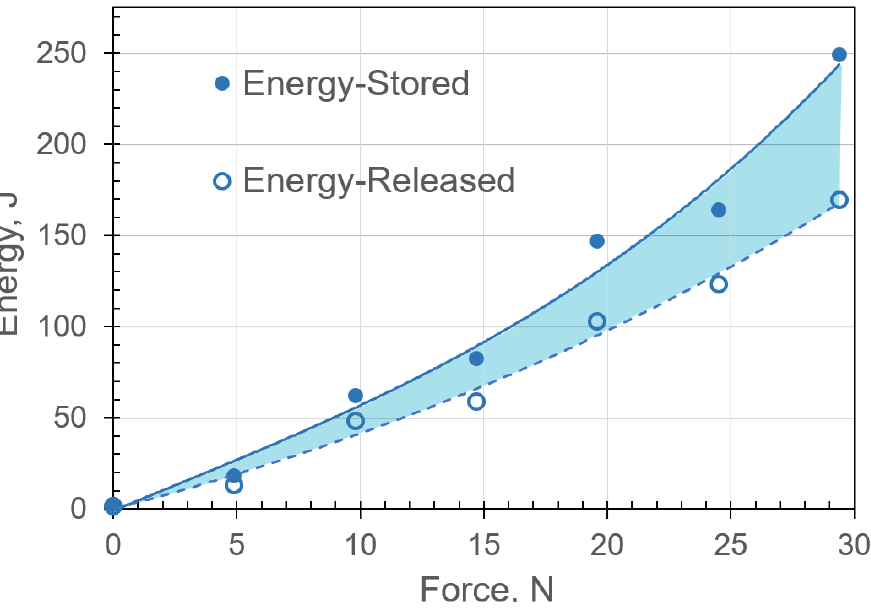
Figure 17. Total elastic energy storage for the musculoskeletal system in the bending load configu- ration. The energy released was the energy stored minus the energy dissipated. Experimental and analytical (from (11)) results are shown in markers and lines,